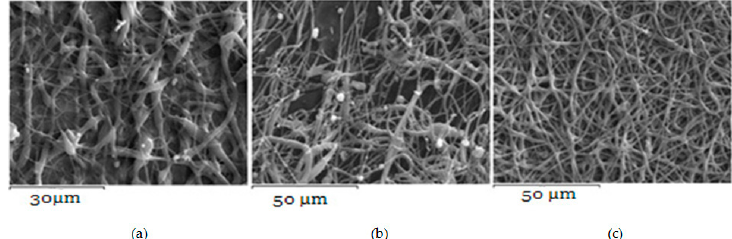
Figure 1. Poly( ε -caprolactone) (PCL) fibers produced by a 20 wt % PCL solution using as solvent: ( a ) DCM; ( b ) DCM/Acetone (70/30 v / v ); and ( c ) DCM/DMF (70/30 v / v ).